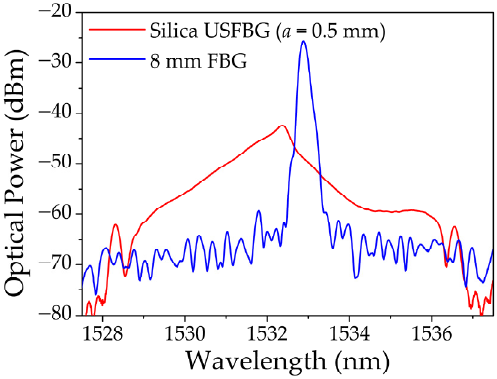
Figure 8. Reflection spectra of the 8 mm FBG and USFBG in silica fiber employed in the sensing tests.